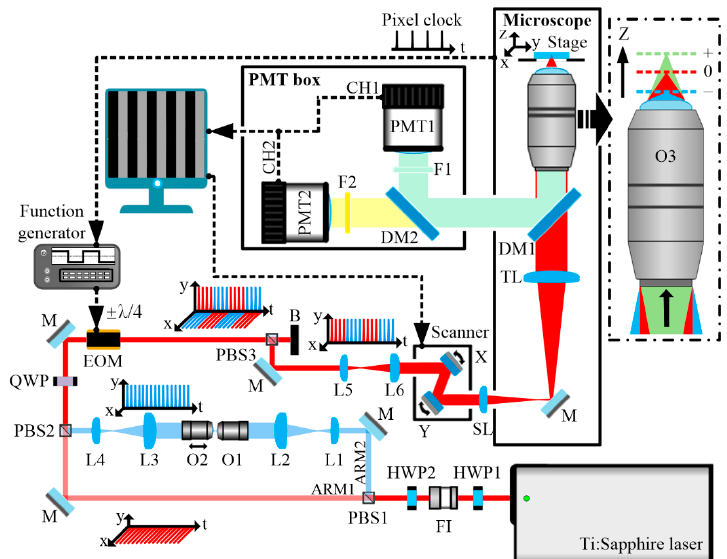
Figure 1. Experimental setup of a real-time multidepth multiphoton imaging system. The excitation beams are shown in red and blue, and generated signals at different wavelength ranges are shown in green and yellow. The electrical paths are indicated in dashed black lines. HWP1, HWP2, half-wave plates; FI, Faraday isolator; PBS1, PBS2, PBS3, polarizing beam splitters; M, mirror; L1, L2, L3, L4, L5, L6, lenses; O1, O2, O3, objectives; QWP, quarter-wave plate; EOM, electro-optic modulator; B, blocker; SL, scan lens; TL, tube lens; DM1, DM2, long pass dichroic mirrors; F1, F2, bandpass filters; PMT1, PMT2, photomultiplier tubes. This figure is not to